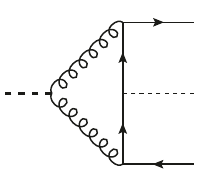
Figure 4 . One-loop diagram responsible for the mixing of the Wilson coe(cid:14)cients c ^ Y q described by